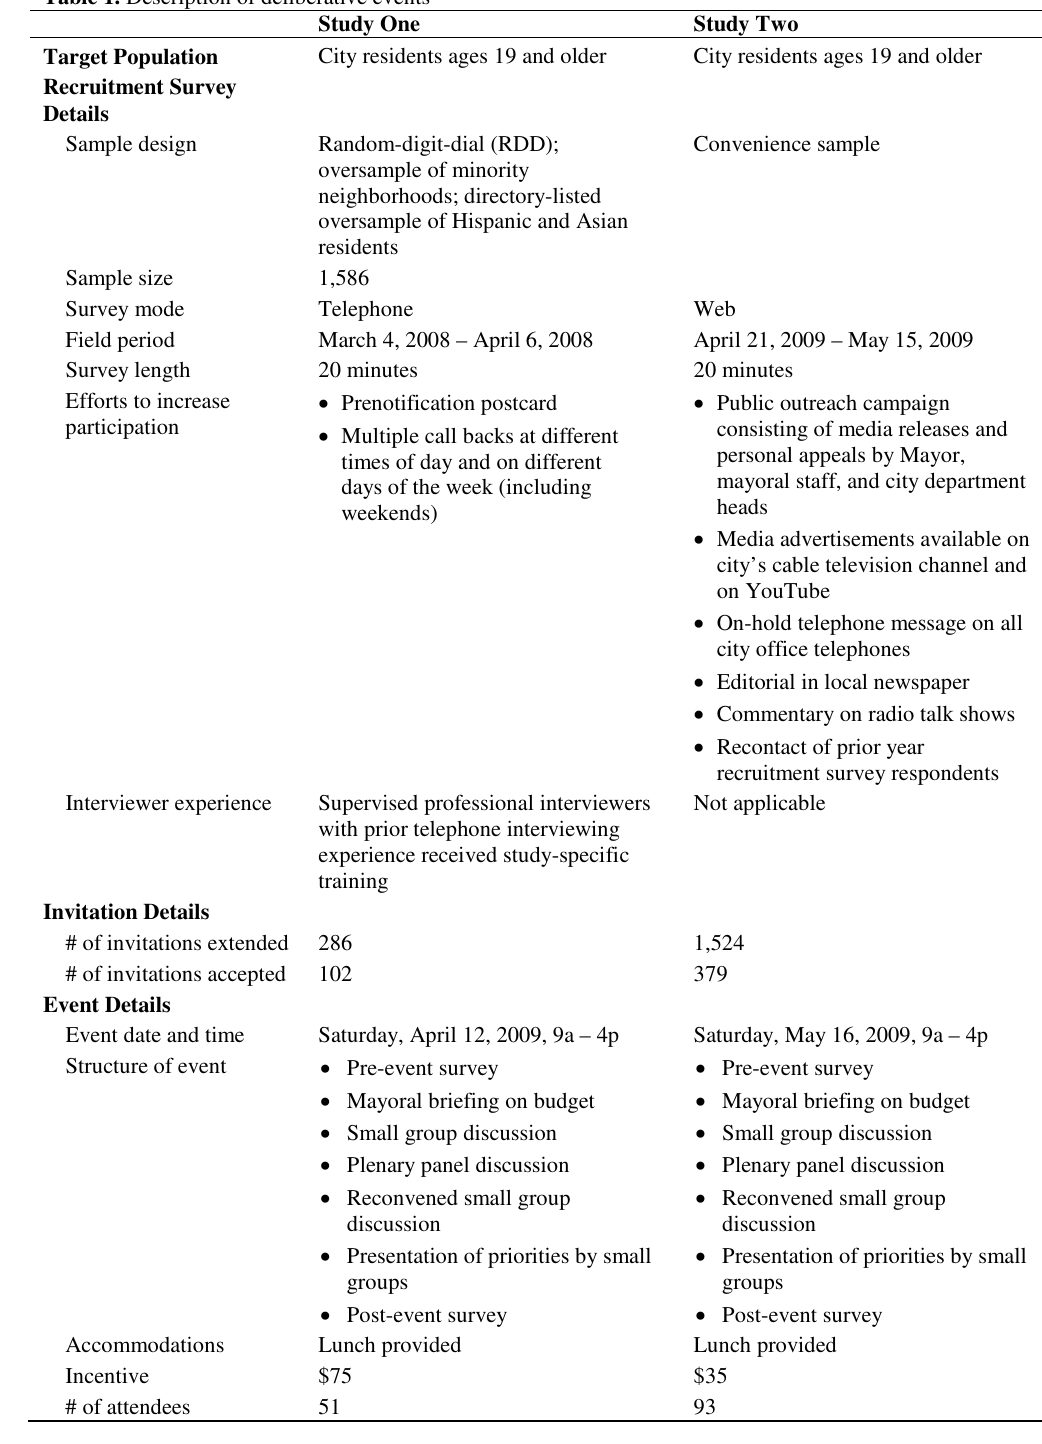
Table 1. Description of deliberative